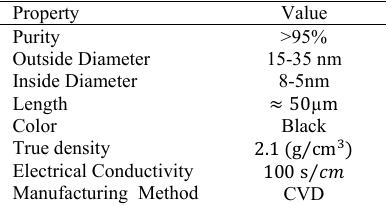
Table 2. Physical properties of MWCNT-COOH.